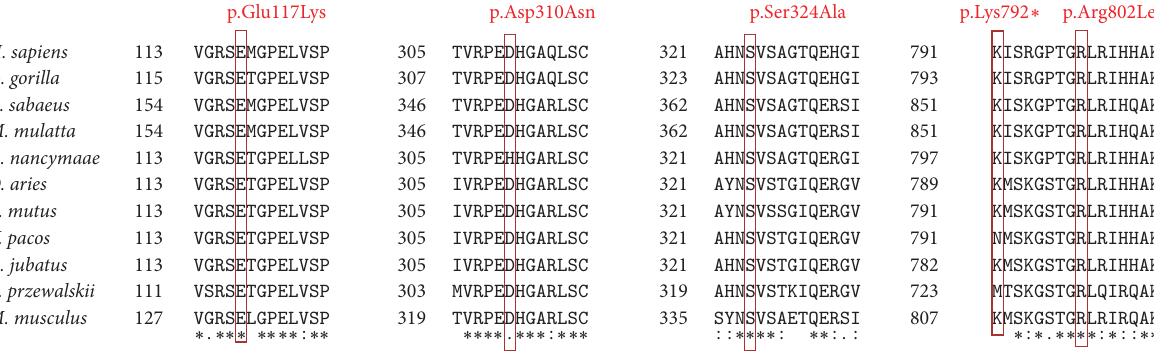
Figure 4: Alignment of amino acid sequences of NPHS1 from different species such as Chlorocebus sabaeus (XM007996435), Aotus nancy- maae (XM012437656), Homo sapiens (NM004646), Macaca mulatta (XM015123713), Bos mutus (XM005908211), Ovis aries (XM012190201), Equus przewalskii (XM008543338), Acinonyx jubatus (XM015072043), Gorilla gorilla (XM004060548), Vicugna pacos (XM006217092), and Mus musculus (AF191090). The positions of the changed amino acids (p.Glu117Lys, p.Asp310Asn, p.Ser324Ala, p.Lys792 ∗ , and p.Arg802Leu) in protein